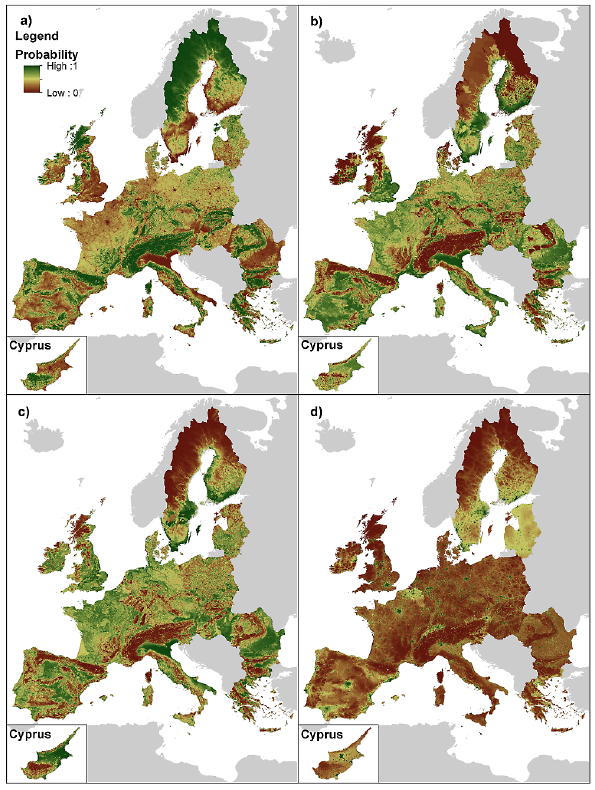
Fig. 1. Probability maps for each land cover class (forest a , cropland b , grassland c , settlement d ) calculated based on regression analysis conducted by (Verburg and Overmars, 2009). High probability val- ues are in green, low probability values are in red. The Other land class has no probability map, because it is treated differently.